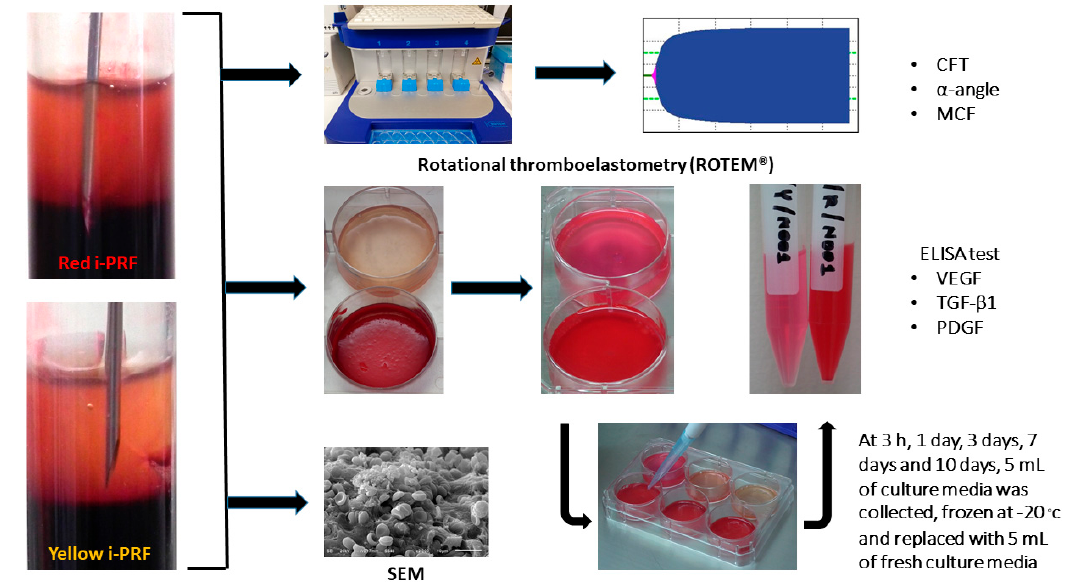
Figure 4. Study workflow of three experiments comparing the red and yellow i-PRF and their fractionation protocol used in this study.